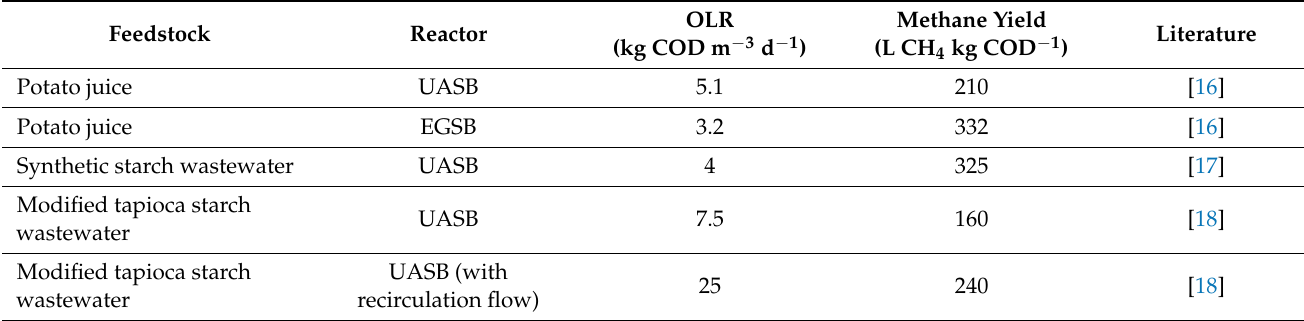
Table 1. Methane yields and organic loading rates from different starch wastewaters in UASB/EGSB lab-scale reactors.